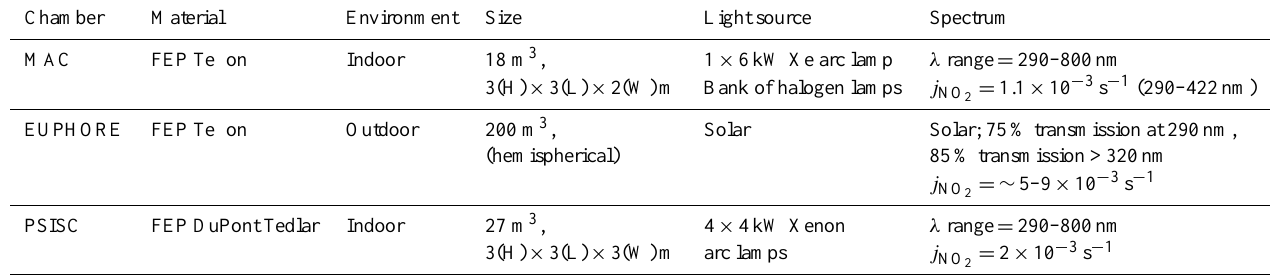
Table 2. Key technical features of MAC, EUPHORE and PSISC (Alfarra et al., 2012; Becker, 1996; Bloss et al., 2005; Camredon et al., 2010; Paulsen et al., 2005; Zador et al.,